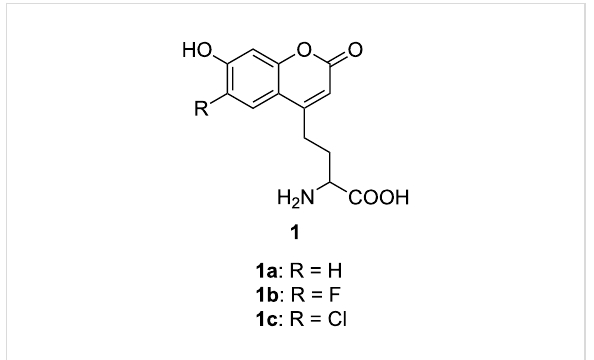
Figure 1: The chemical structure of a series of fluorescent amino acids. ( 1a ) α -(2-(7-hydroxycoumarin-4-yl)ethyl)glycine; ( 1b ) α -(2-(6- fluoro-7-hydroxycoumarin-4-yl)ethyl)glycine; ( 1c ) α -(2-(6-chloro-7-